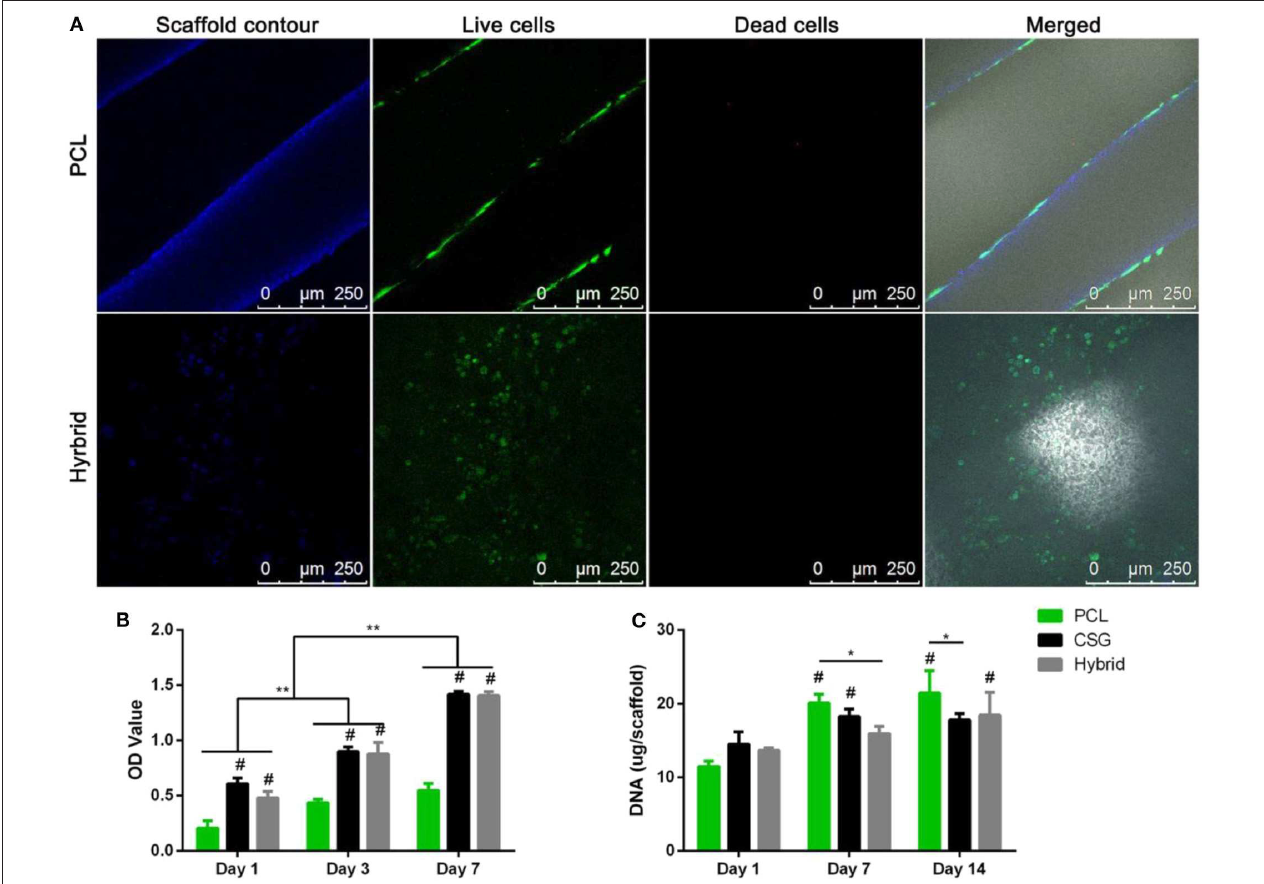
FIGURE 3 | (A) Representative images of BMMSCs attachment, viability, and distribution in composite scaffolds. Blue fluorescence represents the contours of scaffolds; merged images include bright field views to show the scaffold pores. CLSM images of Live/Dead staining demonstrated cell viability of after 72h of culture in growth medium. (Red represents the dead cells; green represents the live cells; Scale bar = 250 µ m). CCK-8 assay showed that the number of cells in the three groups increased over time (B) . DNA content in the various scaffolds during osteogenic culture indicating slow proliferation while MSCs differentiating into osteoblasts. Results are expressed as mean ± SD ( n = 3, * , # P < 0.05, ** , ## P < 0.01; # compared to PCL group in (B) , and compared to day 1 in (C) ). Reproduced from Dong et al. (2017) with permission from Copyright 2017 Springer